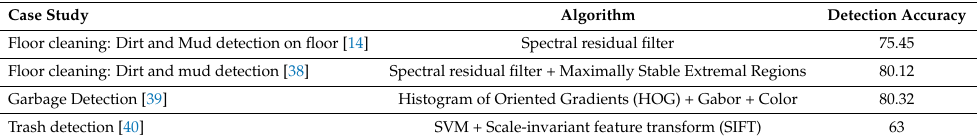
Table 3. Non-Deep Learning Based Detection.